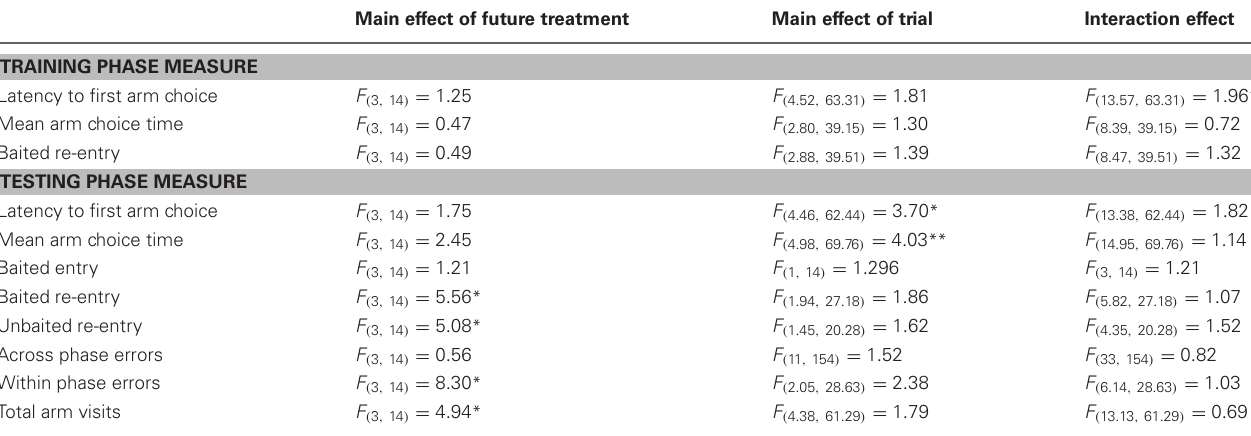
Table 3 | Results of 1 within (TRIAL), 1 between (FUTURE TREATMENT) ANOVA on the DSWT using a 3h delay demonstrate that there were some differences between the four treatment groups used for the 6h delay prior to any